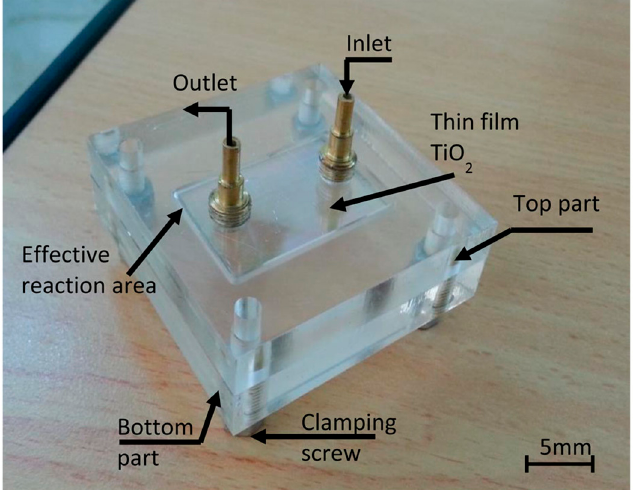
Figure 10. Miniaturized photocatalytic reactor for the degradation of Novacron Red C-2BL dye. Reprinted from [107].